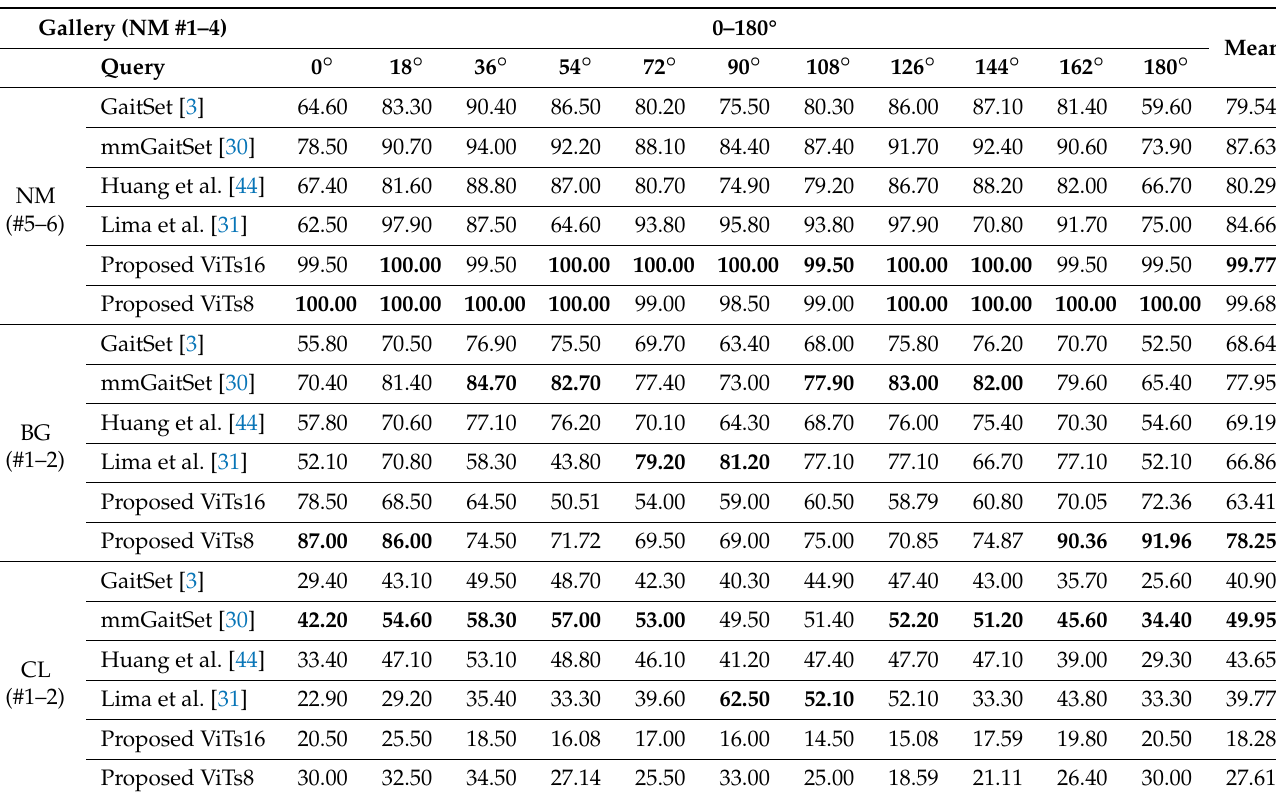
Table 1. Results for CASIA-B dataset ST setting. The best results for each angle and overall are in